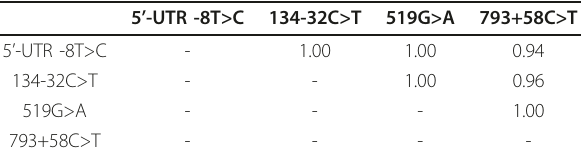
Table 3 D ’ Values for Linkage Disequilibrium (LD) between RPSA polymorphisms